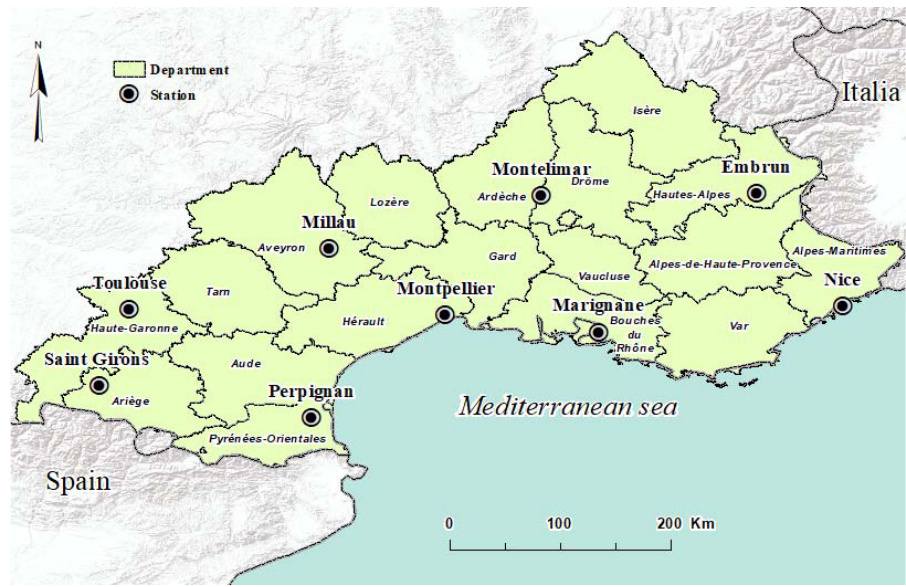
Figure 1. The locations of stations and departments in the study area.